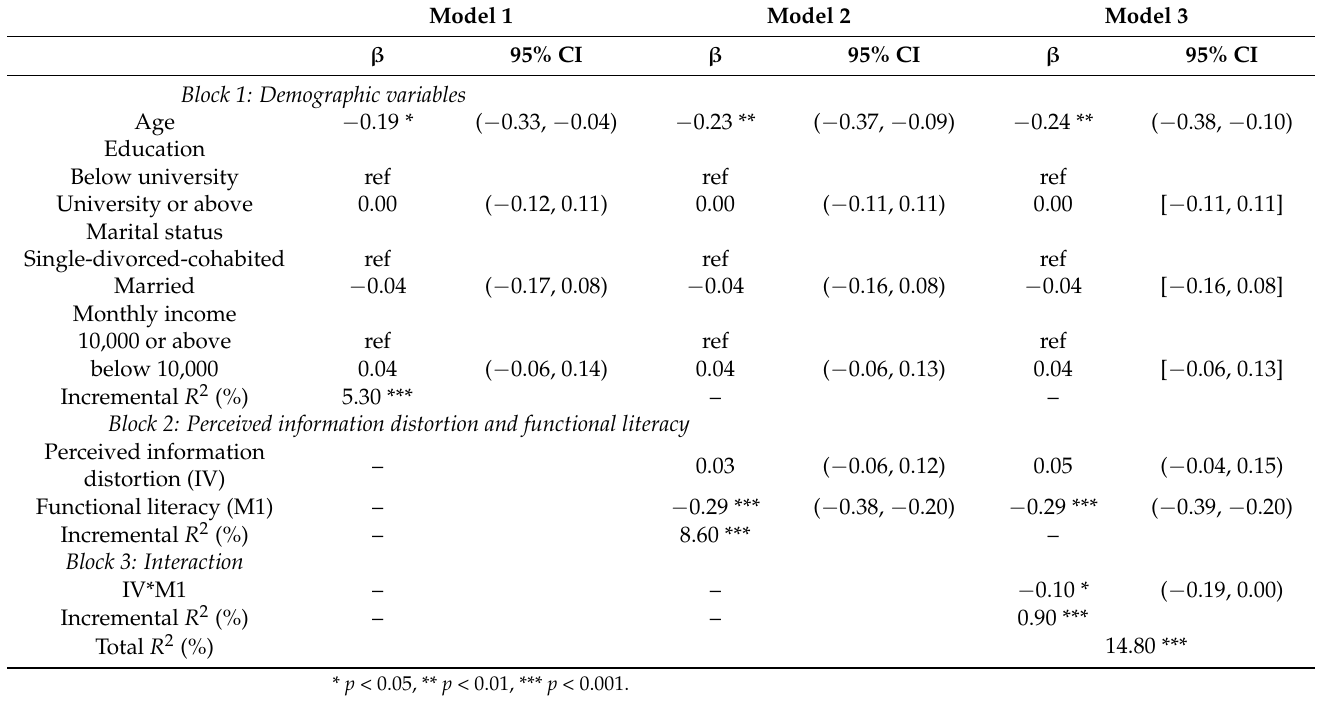
Table 3. Hierarchical regression analysis of perceived information distortion and functional literacy on addictive SMU (N = 411).